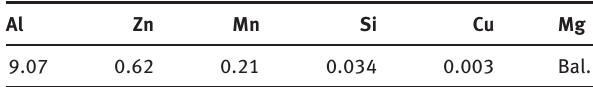
Table 3: Chemical composition of AZ91D Mg alloy (wt.%).